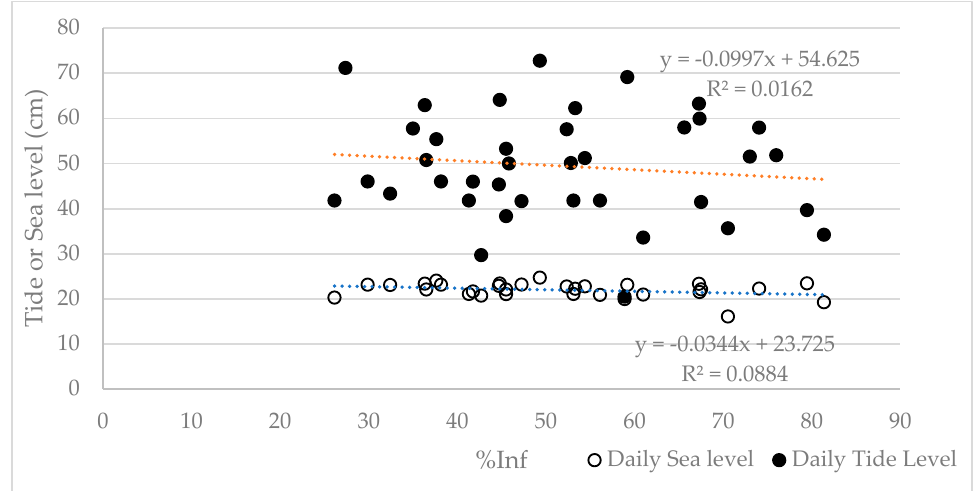
Figure 7. Correlation of infiltration efficiency with tide/sea level.